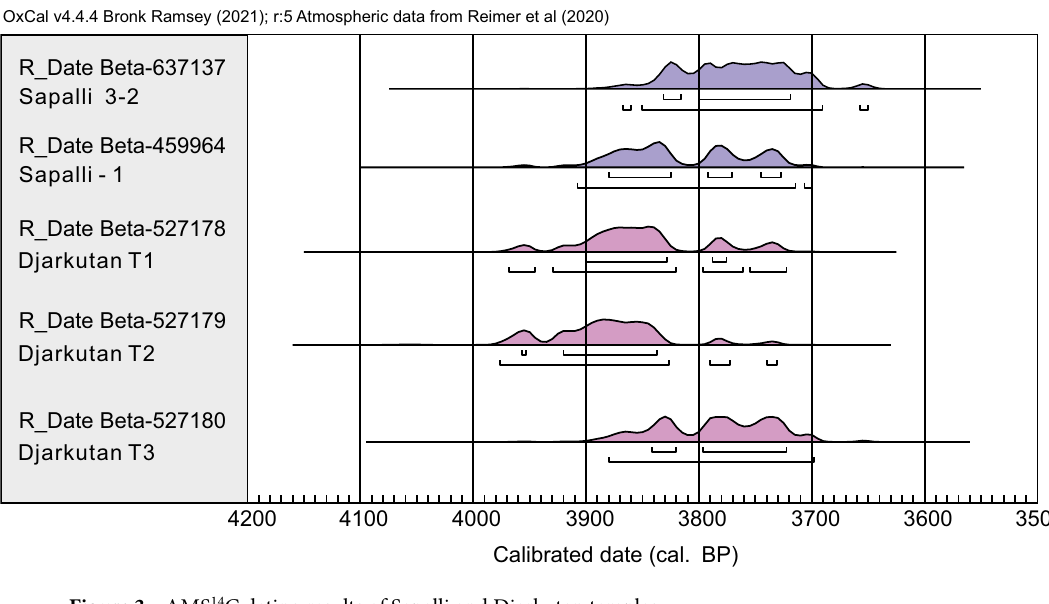
Figure 3. AMS 14 C dating results of Sapalli and Djarkutan